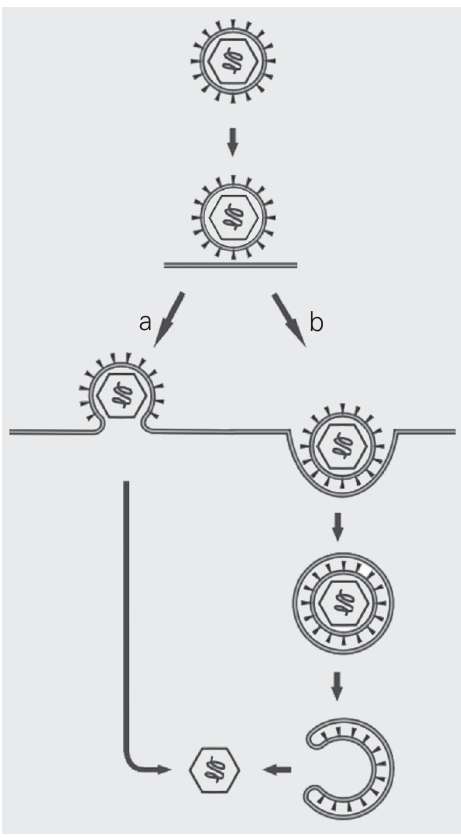
Figure 1. Entry of enveloped vi- rus into the host cells. First, the virion attaches to the cell sur- face through the interaction be- tween a viral envelope protein and a receptor molecule, lead- ing to (a) pH-independent fusion between viral envelope and host cell plasma membrane or to (b) endocytosis of the virus particle, followed by fusion of the endo- somal membrane with the viral envelope at low pH. After mem- brane fusion, the viral genome is released into the cytosol to be replicated, transcribed and trans- lated. In both cases, membrane fusion is mediated by specific viral surface glycoproteins, which undergo structural reor- ganization to be converted from the nonfusogenic to the fuso- genic